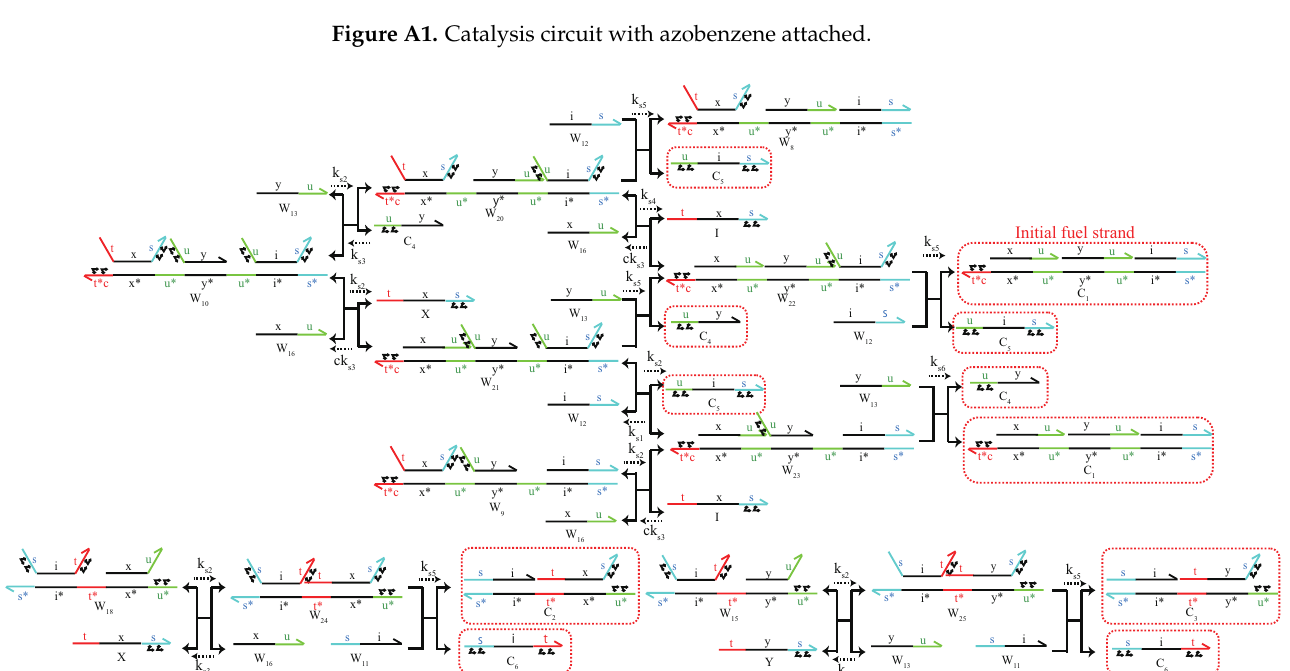
Figure A2. New reaction in catalysis circuits caused by azobenzene attachment.